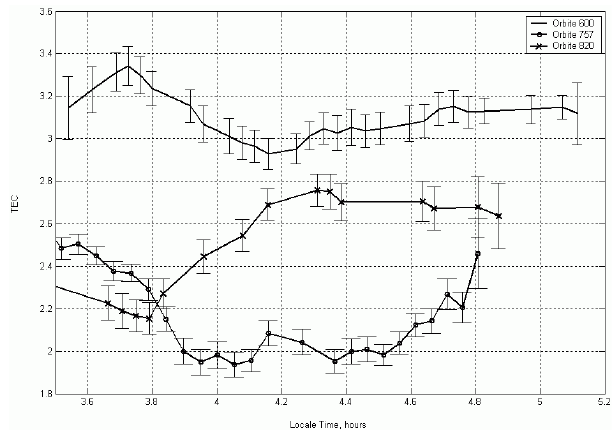
Fig. 3. Temporal variations of TEC (in TECU = 10 16 el × m − 2 ) for three sample